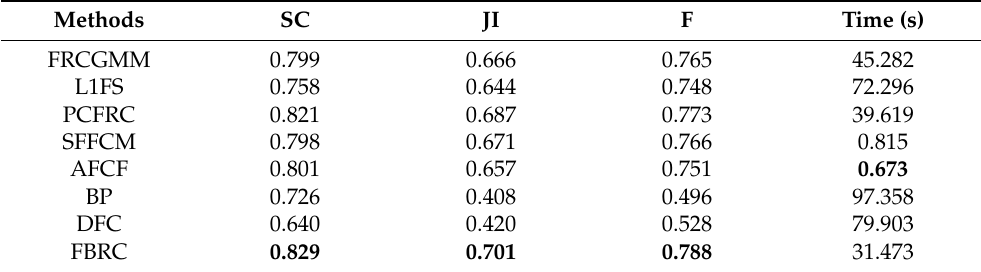
Table 1. Quantitative comparisons of various approaches for WSE database. The best results are highlighted in bold.